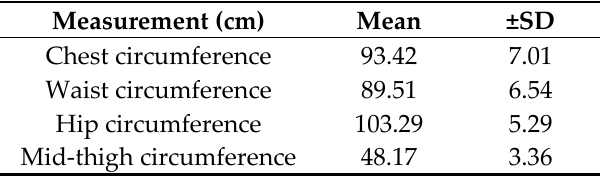
Table 1. Key body dimensions of participants ( N =